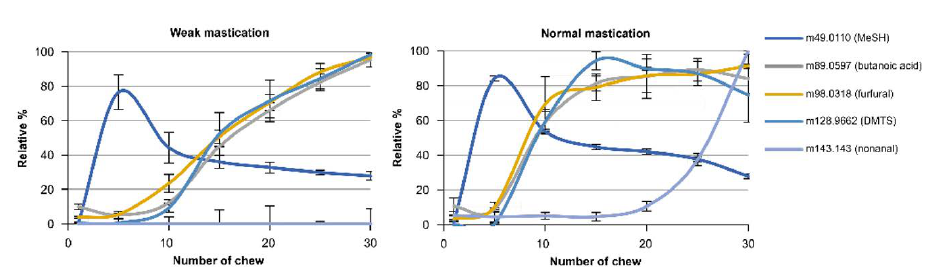
Figure 4. Changes in the release of aroma compounds due to differences in the strengths of mastica- tion and in content of soy protein (release curve). The number of chews means the number of cycles of the chewing simulator jaw. Subfigure represents scanning ions measured by